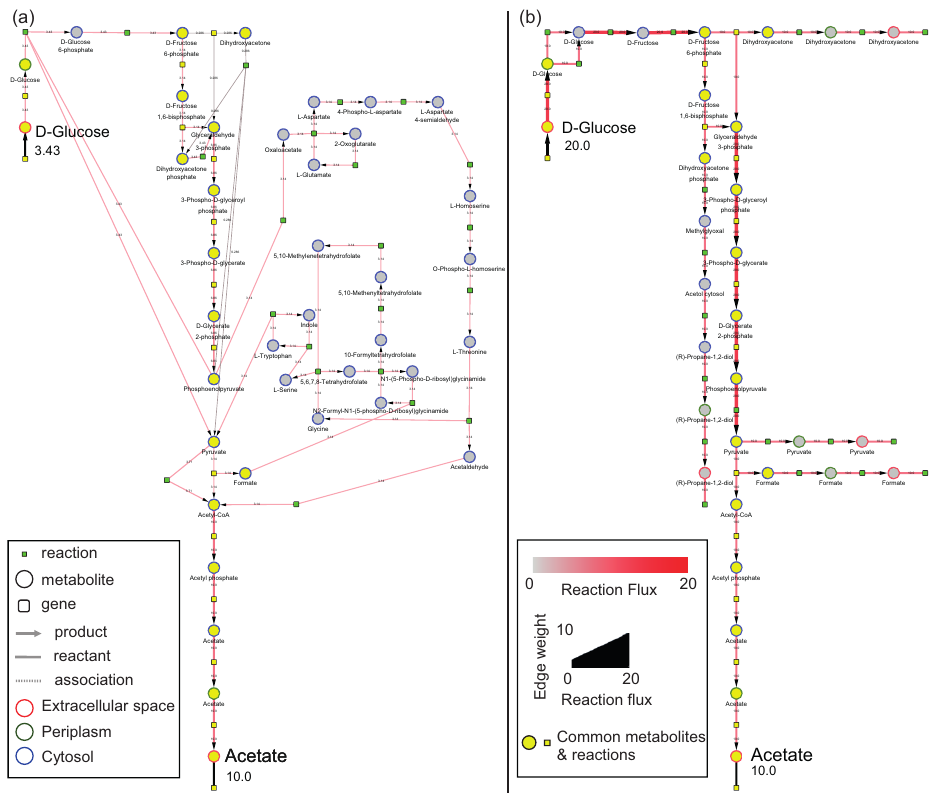
Figure 2. The EFMs from iAF1260 with ( a ) the highest and ( b ) lowest acetate yields on glucose. The uptake and release reactions are highlighted in black. Metabolite node colors indicate the intracellular location, extracellular space (red), cytosol (blue) and peroxisome (green). Relative reaction fluxes, as obtained from EFM calculations, have been mapped on the edges in both the networks. Metabolites and reactions common to both networks are highlighted in yellow. The NDEx links http://bit.ly/2MEQ0v7 and http://bit.ly/2QIrV8f can be used to study the networks